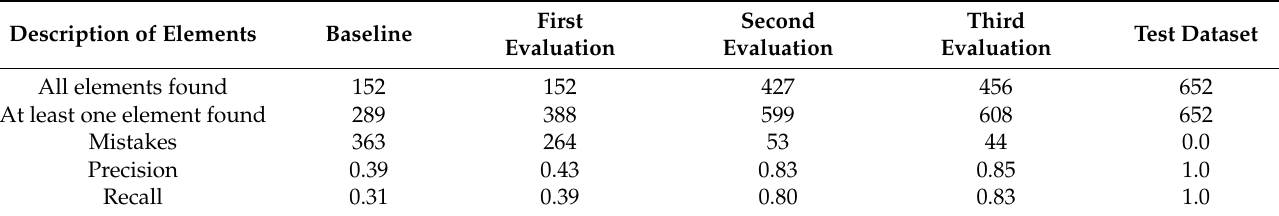
Table 6. Results of the evaluation task, applying precision and recall